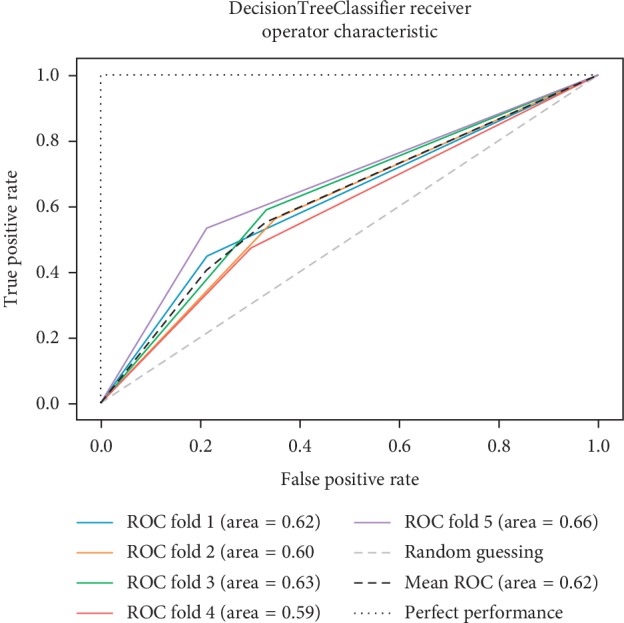
ROC curve for DT.